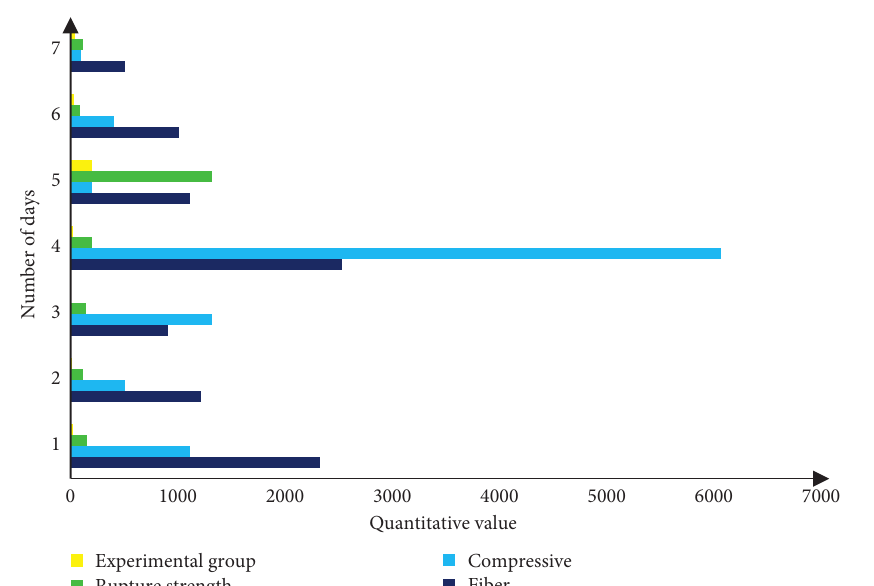
Figure 3: The enhancement of the fiber content to the flexural strength and compressive strength of magnesium phosphate cement-based nanocomposites.